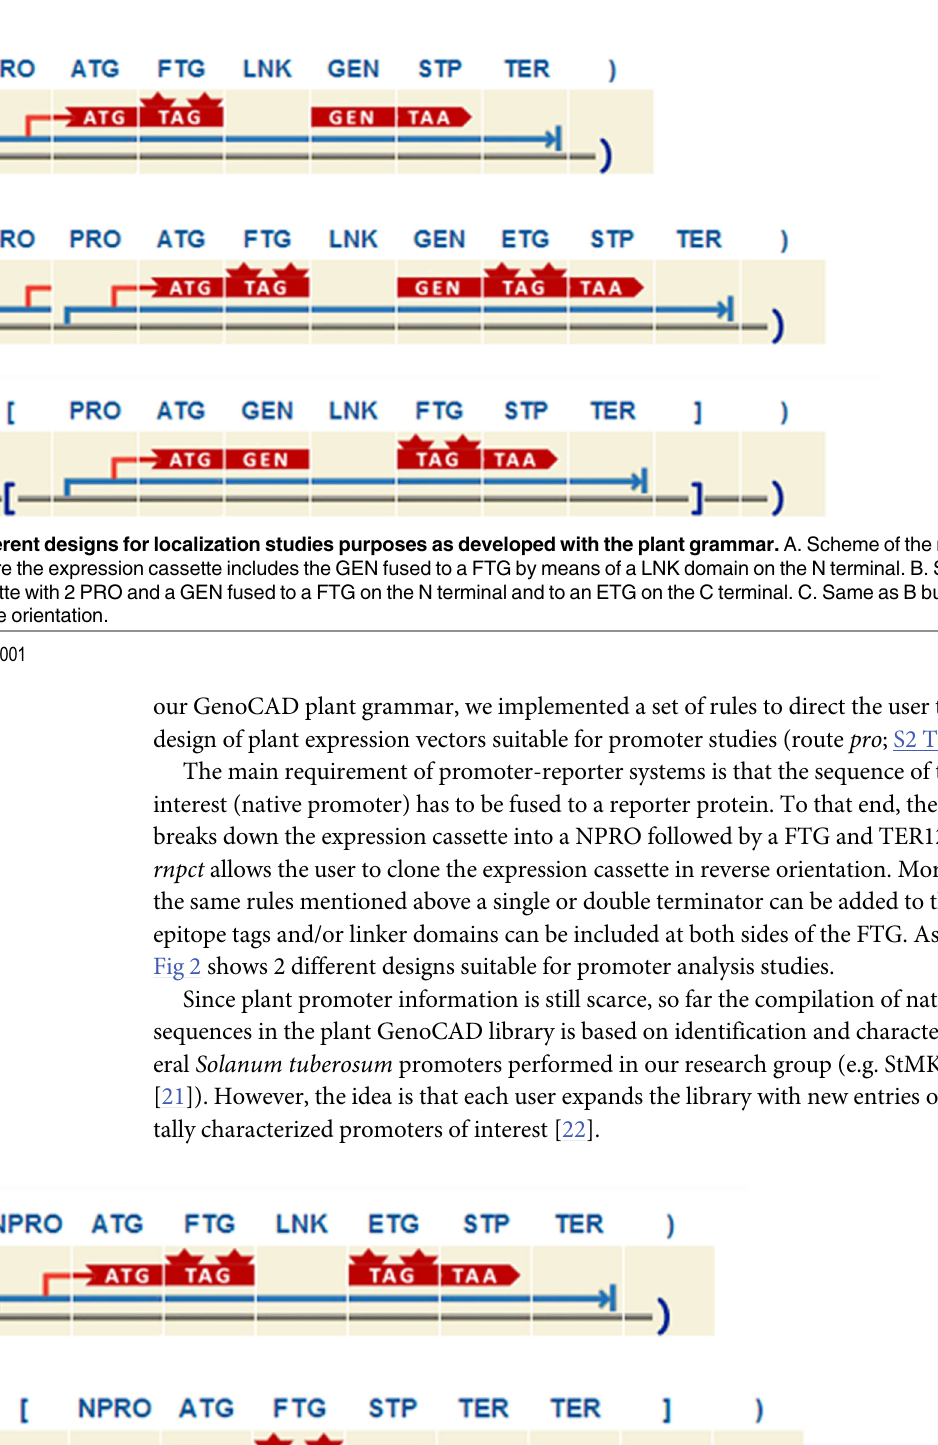
PLOS ONE | DOI:10.1371/journal.pone.0132502 July 6,